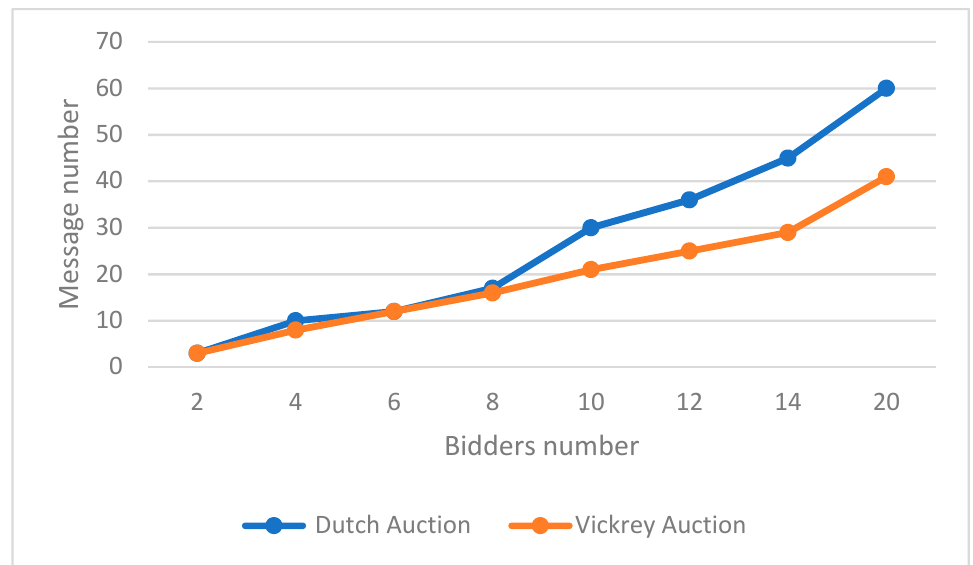
Figure 7. Time required to complete an auction as the number of bidders grows in a demand-driven scenario.